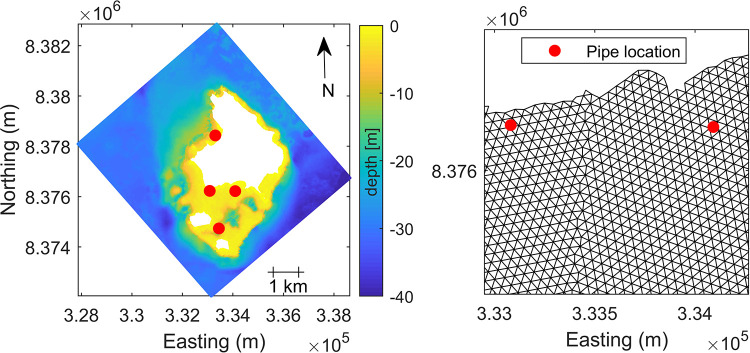
Cool-water injection hydrodynamic grid.Delft 3D FM model. (a) model domain with interpolated bathymetry from [26], location of cool-water injections shown in red; white areas inside model domain indicate dry land. (b) zoom-in on grid mesh south of main island.